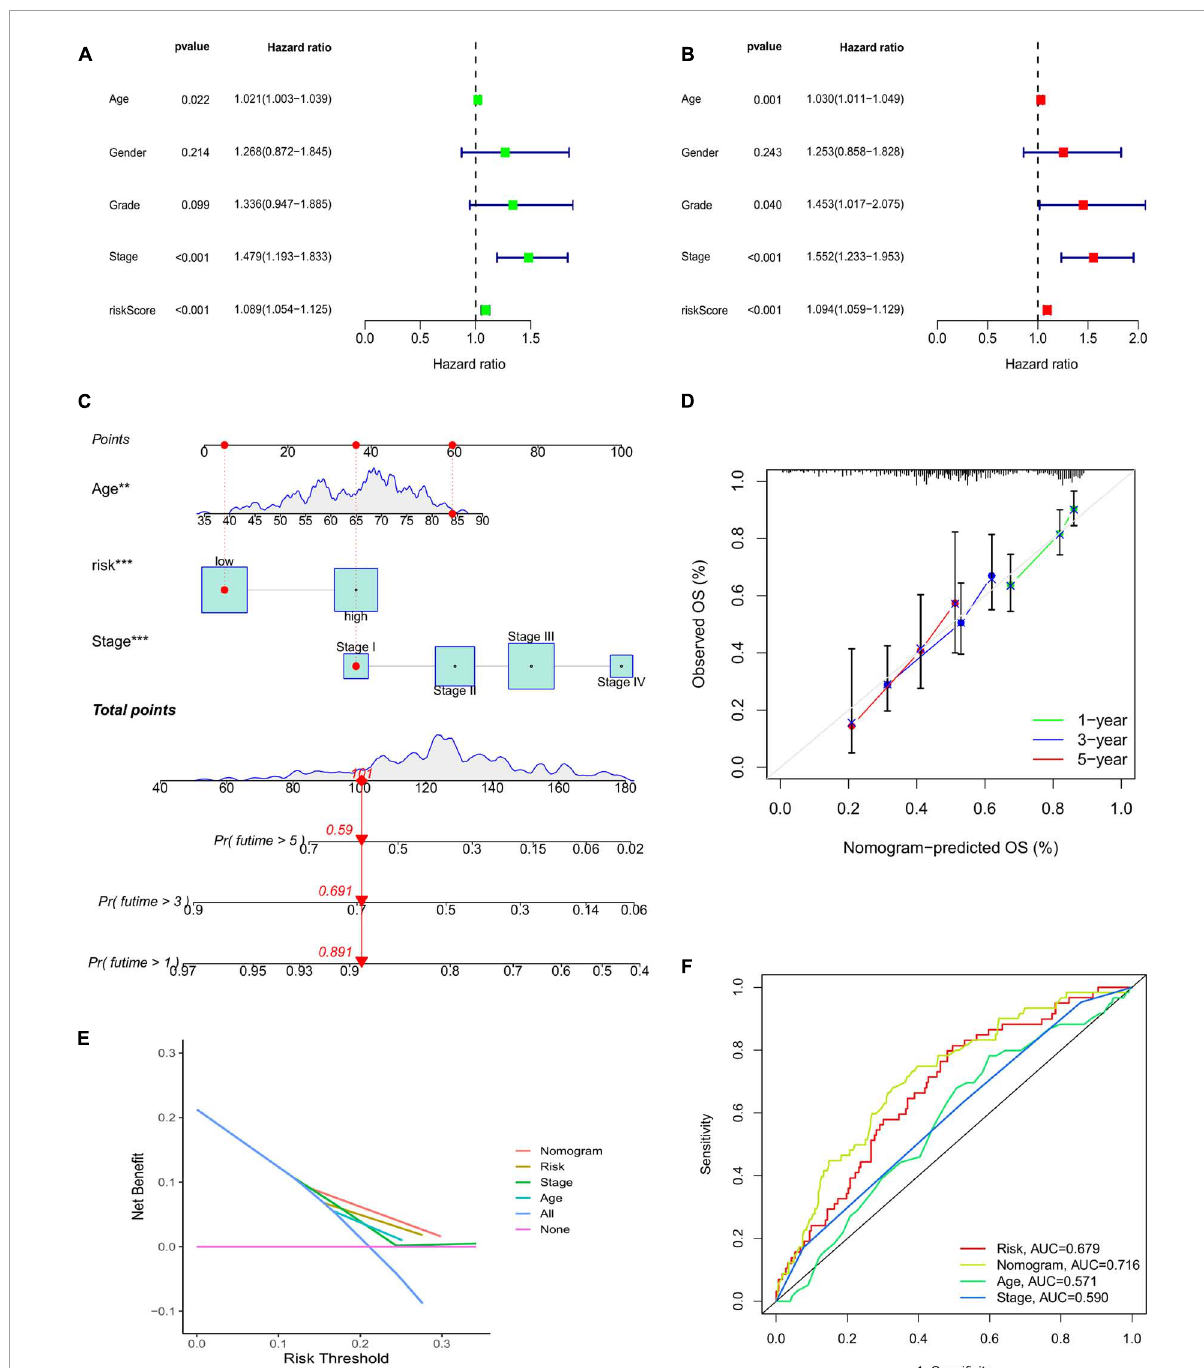
FIGURE5 (A) Univariate Cox regression analysis. (B) Multivariate regression analysis. (C) Nomogram to predict the 1-, 3-, and 5-year survival probability for patients with CRC. (D) The calibration curves of 1-, 3-, and 5-year survival. (E) Decision curve analysis comparing stage, age, risk score, and the nomogram. (F) AUC values of the stage, age, risk score, and nomogram. CRC, colorectal cancer; AUC, area under the